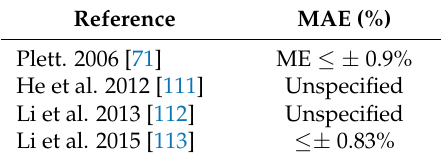
Table 9. MAE/ME of the SPKF and variants of the SPKF-based SOC estimation